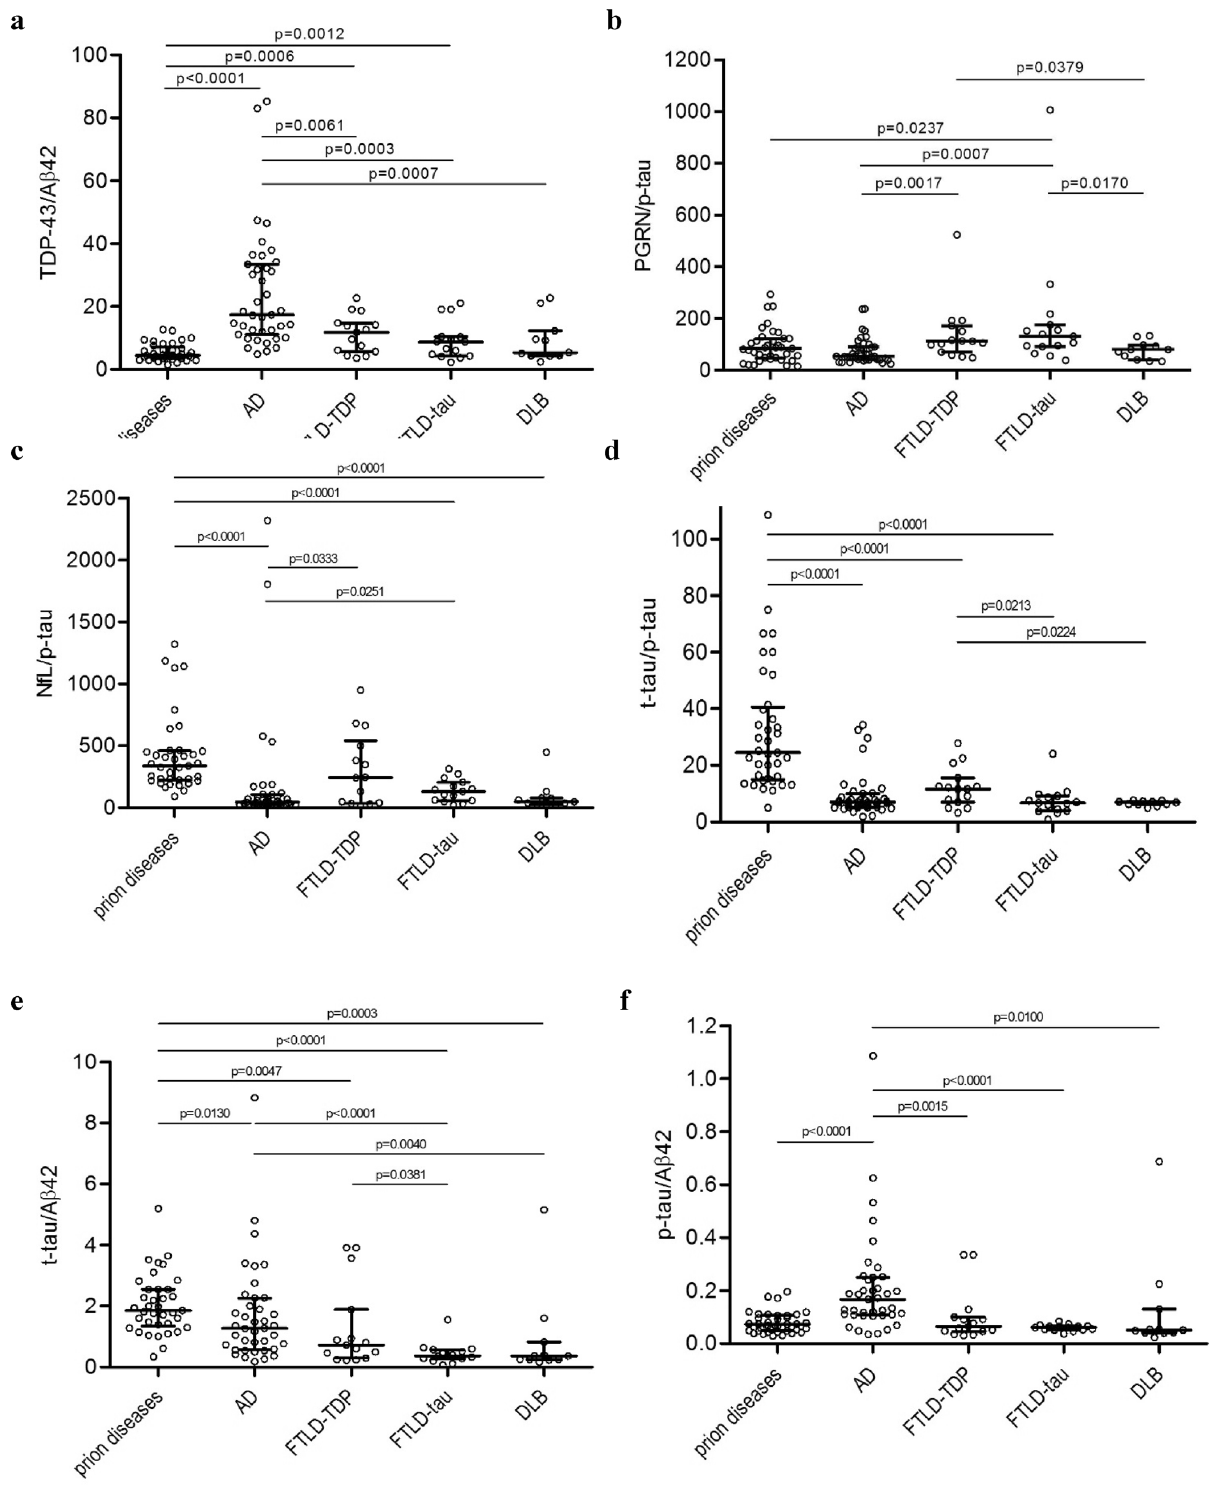
Figure 2. Scatter dot plots represent values of ( a ) TDP-43/Aβ42 ratio, ( b ) PGRN/p-tau ratio, ( c ) NfL/p-tau ratio, ( d ) t-tau/p-tau ratio, ( e ) t-tau/Aβ42 ratio, and ( f ) p-tau/Aβ42 ratio individually for prion diseases, AD, FTLD-TDP, FTLD-tau, and DLB. Bars represent medians with the interquartile range. Statistically significant p-values represent the exact two-tailed p-values of the Mann–Whitney test (p < 0.05). TDP-43, TAR DNA binding protein-43; NfL– neurofilament light chain; t-tau, total-tau; p-tau, phosphorylated-tau (181P); Aβ42, amyloid-beta (1–42); AD, Alzheimer disease; FTLD-TDP, frontotemporal lobar degeneration with TDP-43 inclusions; FTLD-tau, frontotemporal lobar degeneration with tau inclusions; DLB, dementia with Lewy